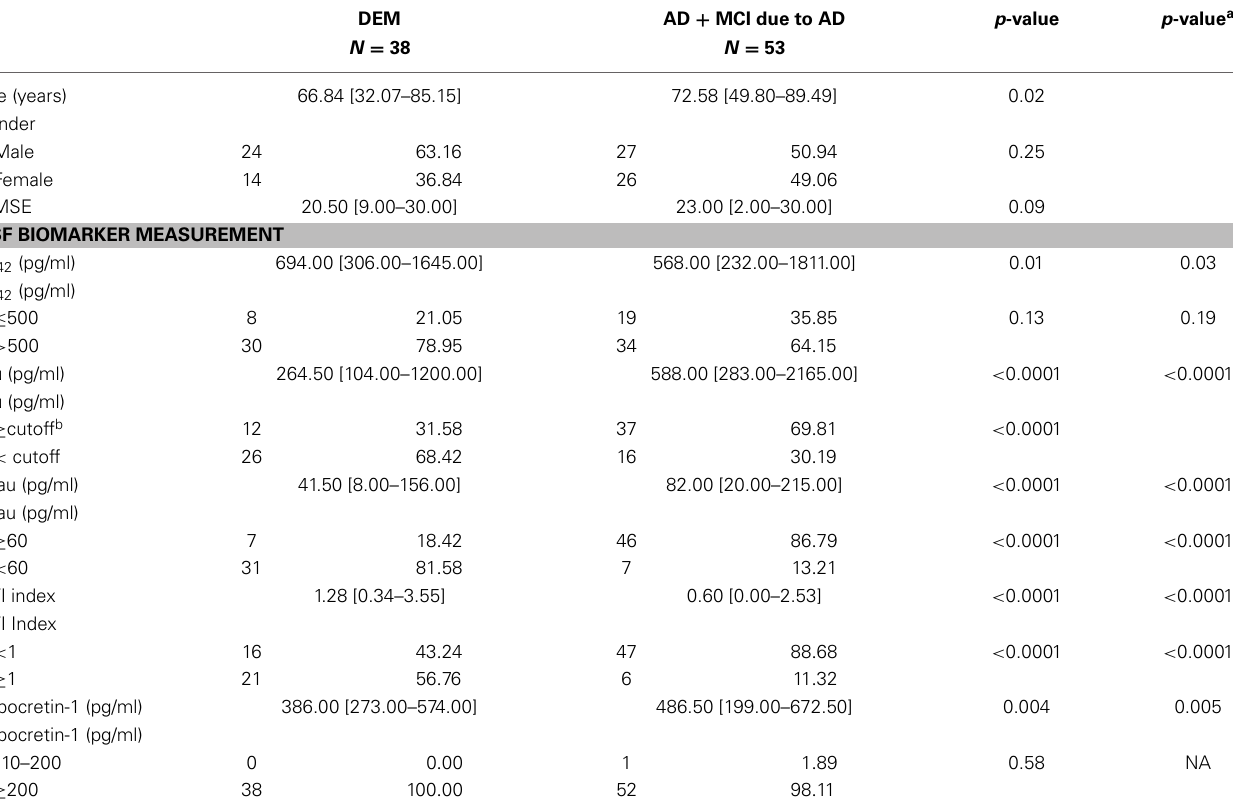
Table 2 | Comparison of sociodemographic, clinical, and biological variables between AD+MCI due to AD patients and patients with other etiology of dementia.